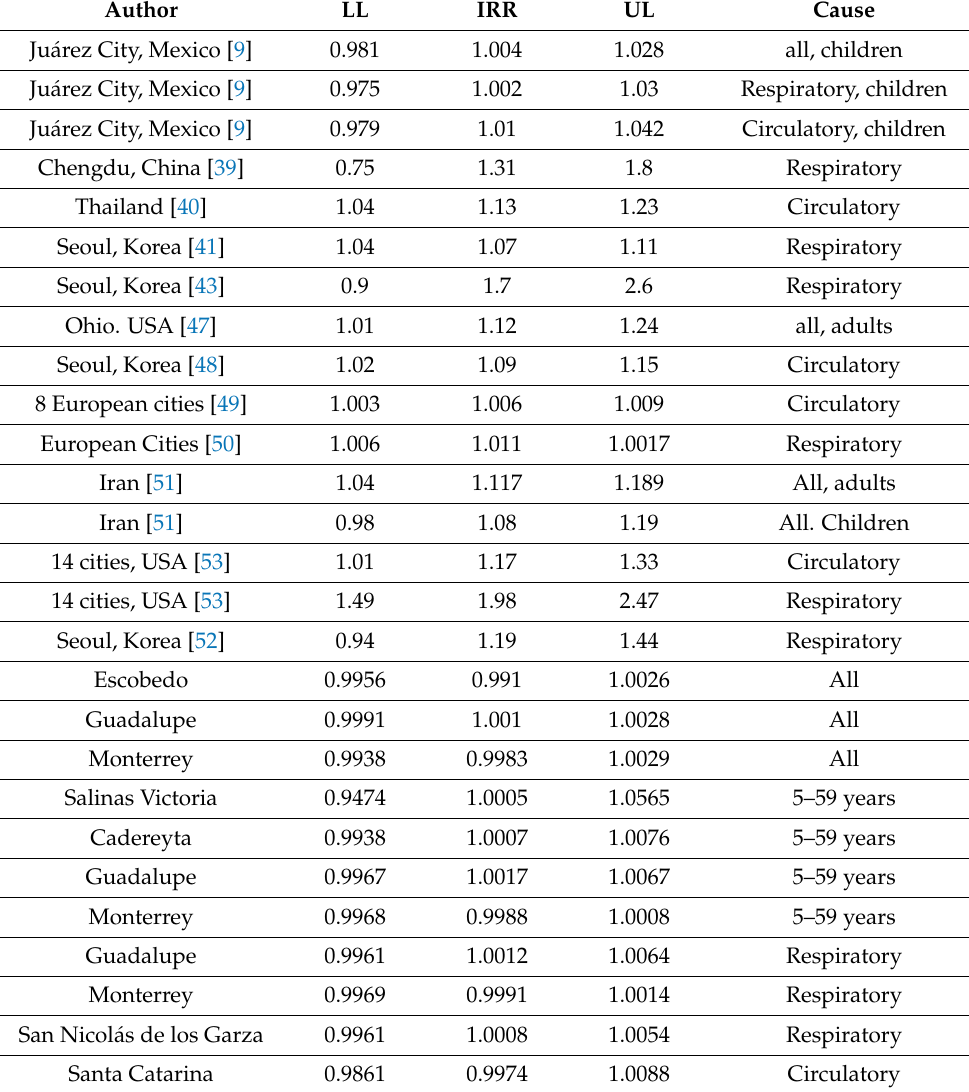
Table 8. RRI, lower and upper limit values found in MAM for PM 10 during the study period, and comparison with values reported by other studies around the